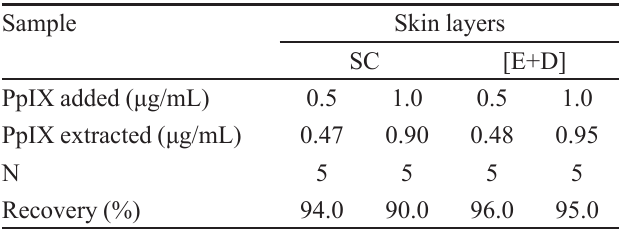
TABLE III - PpIX recovery from SC and [E+D] samples